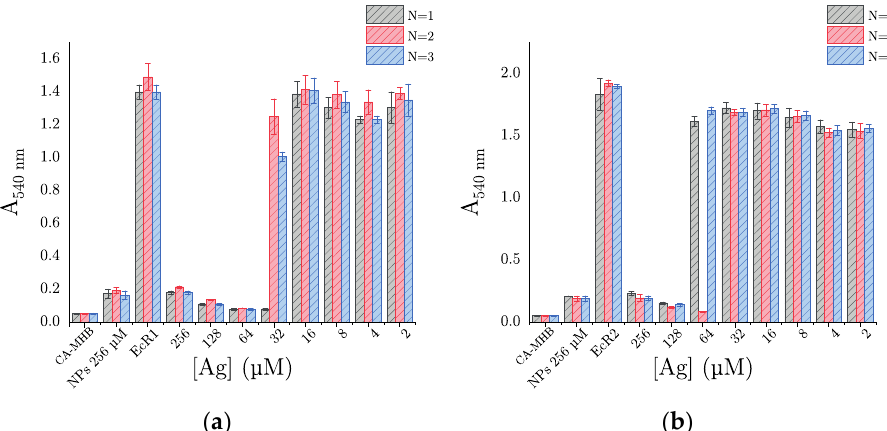
Figure 8. Evaluation of antibacterial activity by broth microdilution method results for AgNPs facing ( a ) EcR1 (ABC 23) penicillinase and ( b ) EcR2 (ABC 24) cephalosporinase. “CA-MHB”: culture medium control (i.e., culture medium free of bacteria and nanoparticles); “NPs 256 µM”: Nanoparticles control (i.e., bacteria-free culture medium, but with nanoparticles at 256 µmol/L); ”EcR1 or EcR2”: Bacterial growth control (i.e., growing bacteria free of nanoparticles).